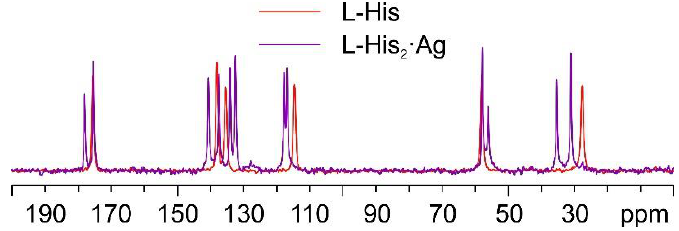
Figure 10. Overlay of the 13 C CPMAS spectra of L-His 2 ·Ag (in purple) and pure L-His (in red).